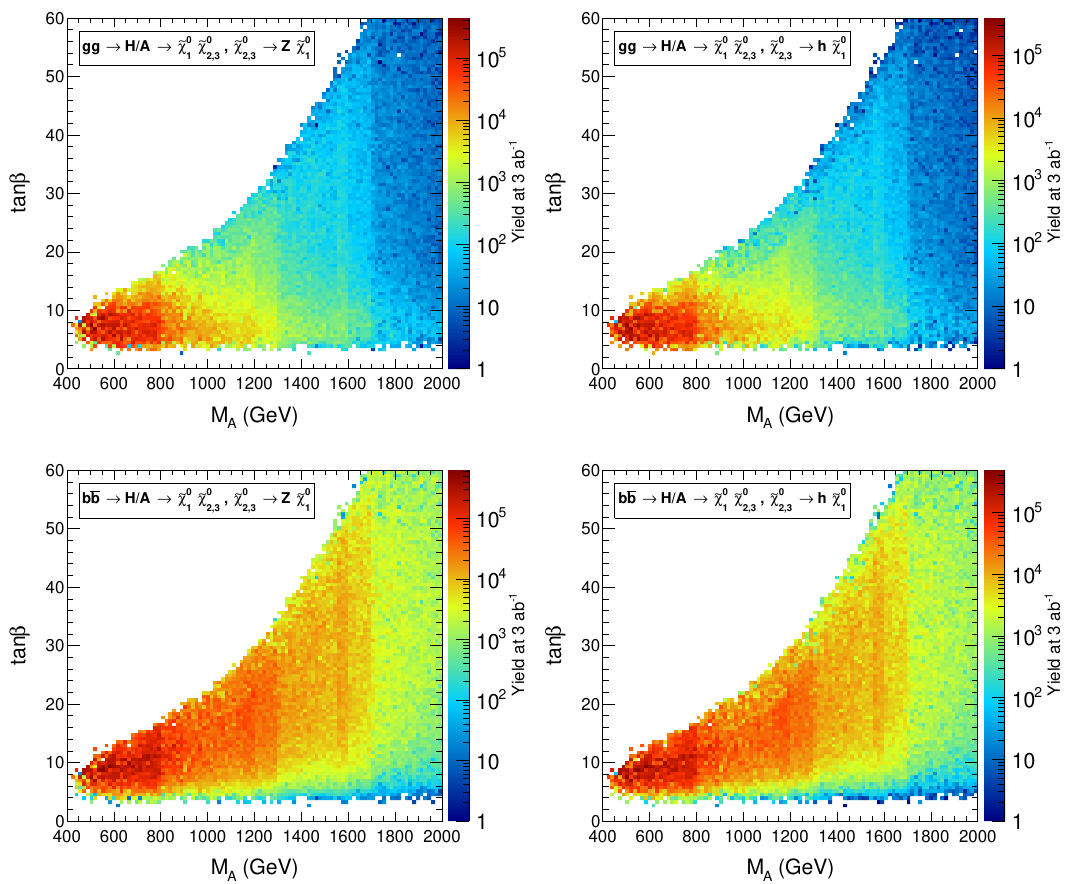
Figure 7. Event yield at 3 ab − 1 of integrated luminosity for all points passing phenomenological constraints for gluon fusion process leading to mono-Z/h final state (top left, top right panel) while the bbH production mode leading to mono-Z/h final state (bottom left, right panel). The plots demonstrate that bbH production in general leads to high event yields for moderate tan β due to enhanced Yukawa